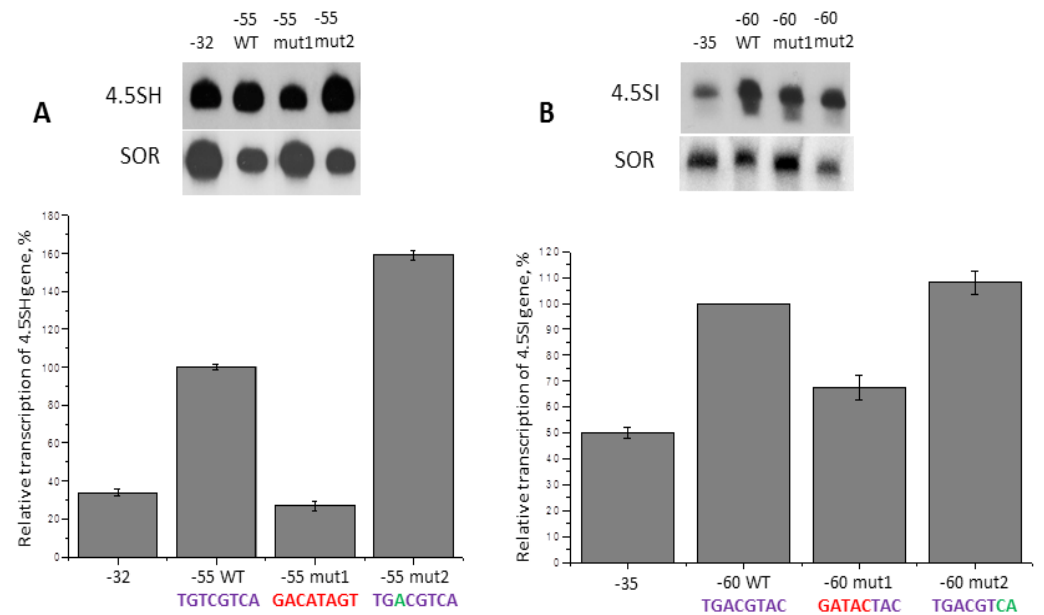
Figure 11. Effect of deletions and substitutions of cAMP-response element (CRE)-like sites in murine 4.5SH RNA ( A ) and 4.5SI RNA ( B ) genes on their transcription. The constructs with deletions up to positions − 32 or − 35 lack CRE sites, while the constructs − 55WT or − 60WT contain them. These sites in mut1 are inactivated by nucleotide substitutions (red), while in mut2 they are converted to canonical CRE sites by replacing one or two nucleotides (green). Error bars, SD, n = 3.